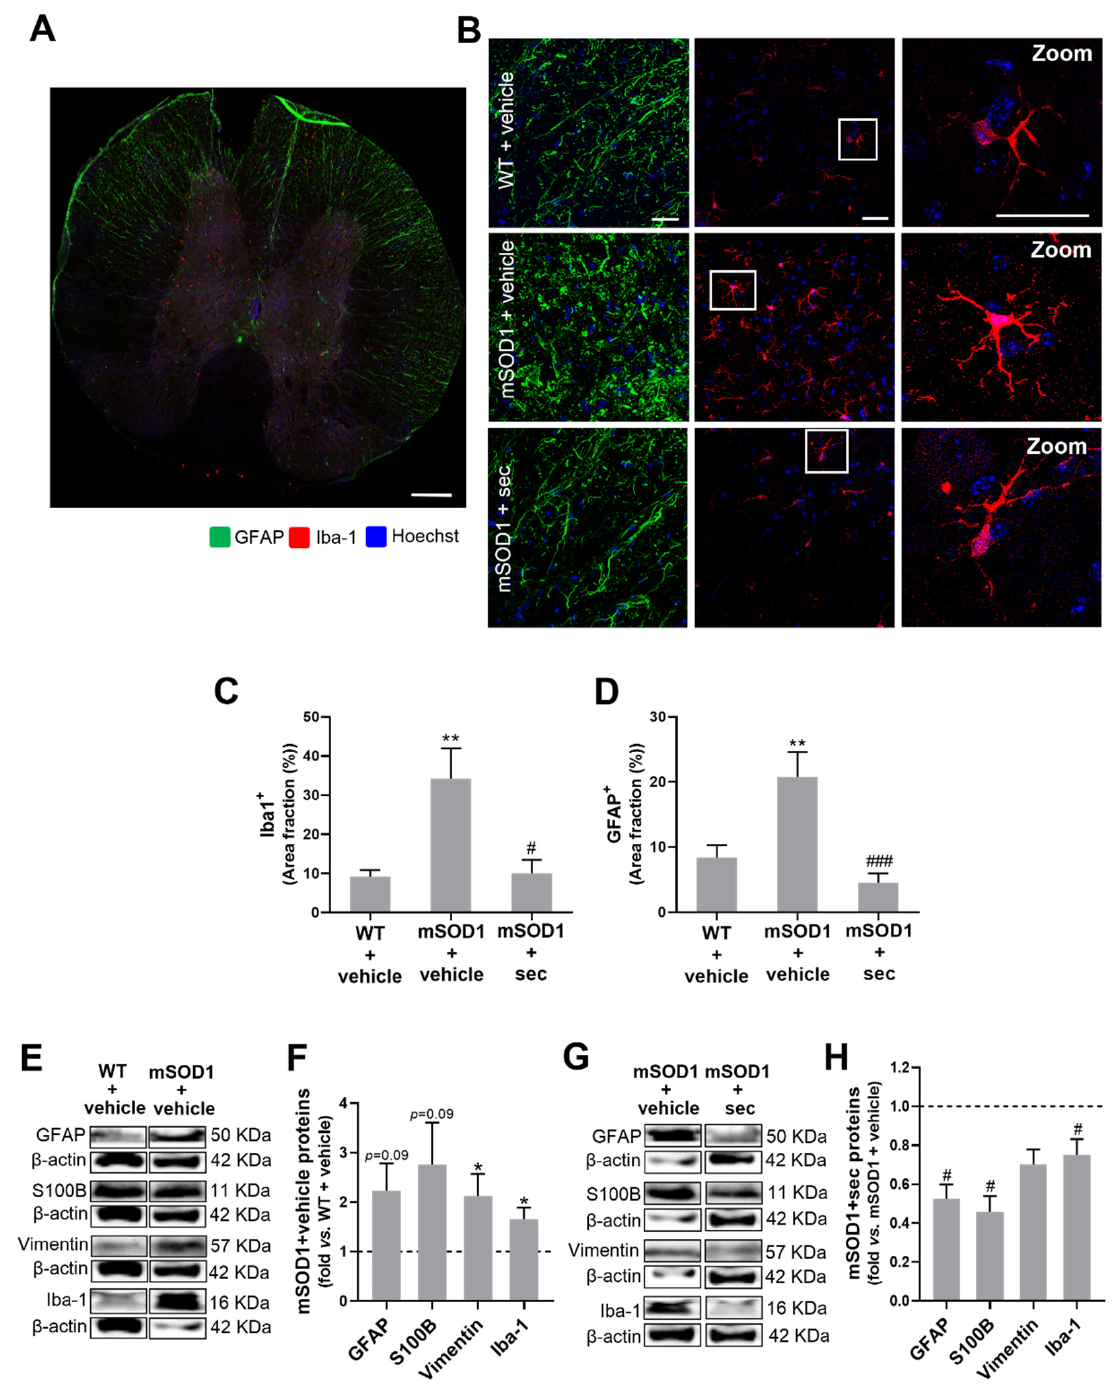
Figure 9. Intrathecal injection of the secretome from anti-miR-124-modulated mSOD1 motor neurons (MNs) in the lumbar spinal cord (SC) of mSOD1 mice at 12-week-old counteracts the upregulation of proteins linked to glia-driven immunoreactivity processes after 3 weeks of its administration. ( A ) Representative image of a transversal SC slice stained with Iba-1 (microglia-associated marker) and glial fibrillary acidic protein/GFAP (astrocyte-associated marker). ( B ) Representative images for GFAP- (green) and Iba-1- (red) positive cells from the lumbar SC of WT and SOD1-G93A (mSOD1) mice injected with the vehicle (basal media of NSC-34 MNs) and mSOD1 mice injected with the secretome derived from anti-miR-124-treated mSOD1 MNs (mSOD1 + sec). A zoomed-in image of an Iba-1-positive cell is shown. Nuclei were stained with Hoechst (blue). Scale bar: ( A ) 300 µm and ( B ) 30 µm. ( C , D ) Area fraction (in percentage, %) occupied by GFAP- and Iba-1-positive cells, respectively. ( E , G ) Representative western blots (WB). ( F , H ) Data resulting from WB analysis of reactive astrocytic markers (GFAP, S100B, and vimentin) and microglial Iba-1. β -actin was used as a loading control for WB analysis. Results are mean (± SEM) for ( C , D ) and expressed as fold change vs. WT + vehicle for ( F ) or fold change vs. mSOD1 + vehicle for ( H ). The images were ana- lysed from five ventral horn fields per animal (from three animals per group) for